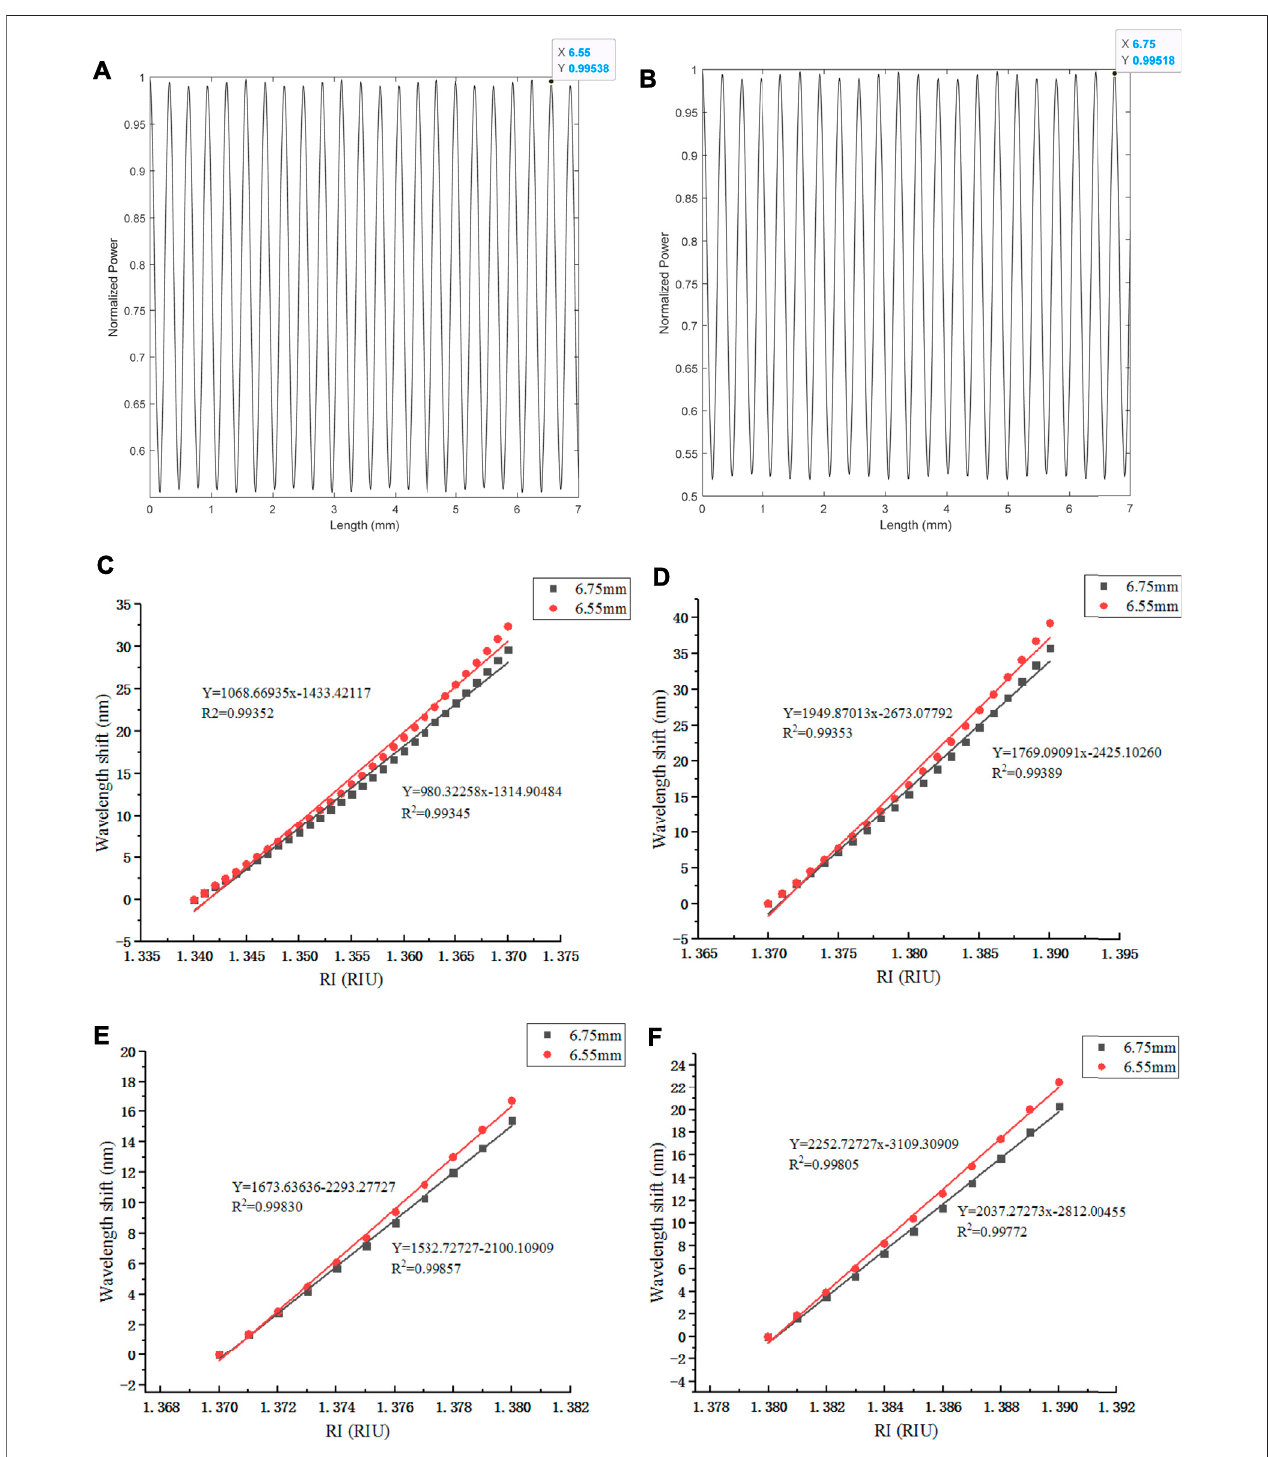
FIGURE 12 | Comparison of NCF normalized power and RI sensitivity at L 3 and L 4 : (A) NCF normalized power of L 3 ; (B) NCF normalized power of L 4 ; (C) comparison of RI sensitivity at 1.340 – 1.370; (D) comparison of RI sensitivity 1.370 – 1.390; (E) comparison of RI sensitivity 1.370 – 1.380; (F) comparison of RI sensitivity 1.380 – 1.390.